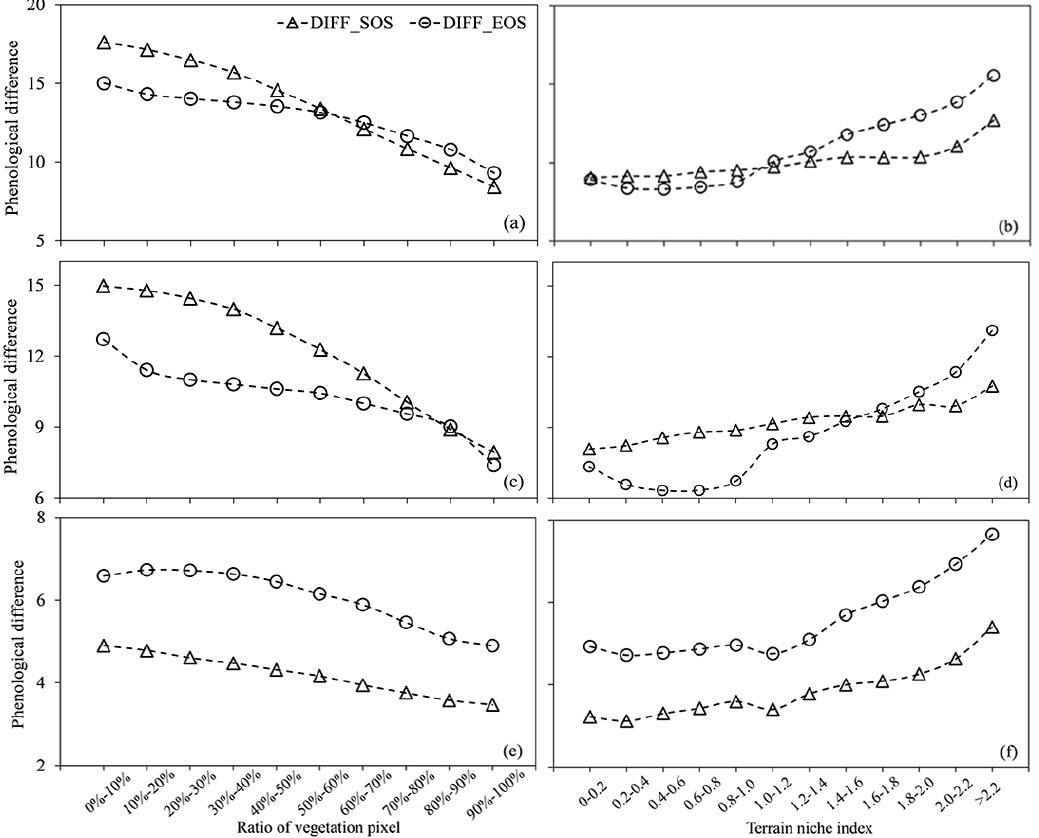
Figure 6. Phenological difference (days) between ( a , b ) LAI and FVC, ( c , d ) FVC and GPP, and ( e , f ) GPP and LAI, varying with the ratio of vegetation pixel (left panels) and terrain niche index (right panels) in 2018 across TRSR.